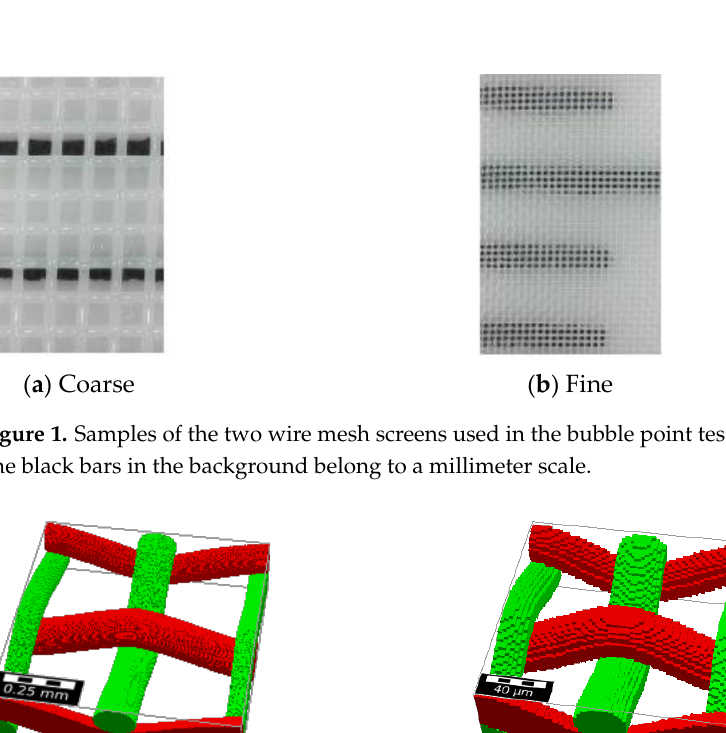
Figure 2. Computer model of a sample of the ( a )coarse and ( b )fine screens created by GeoDict [52].